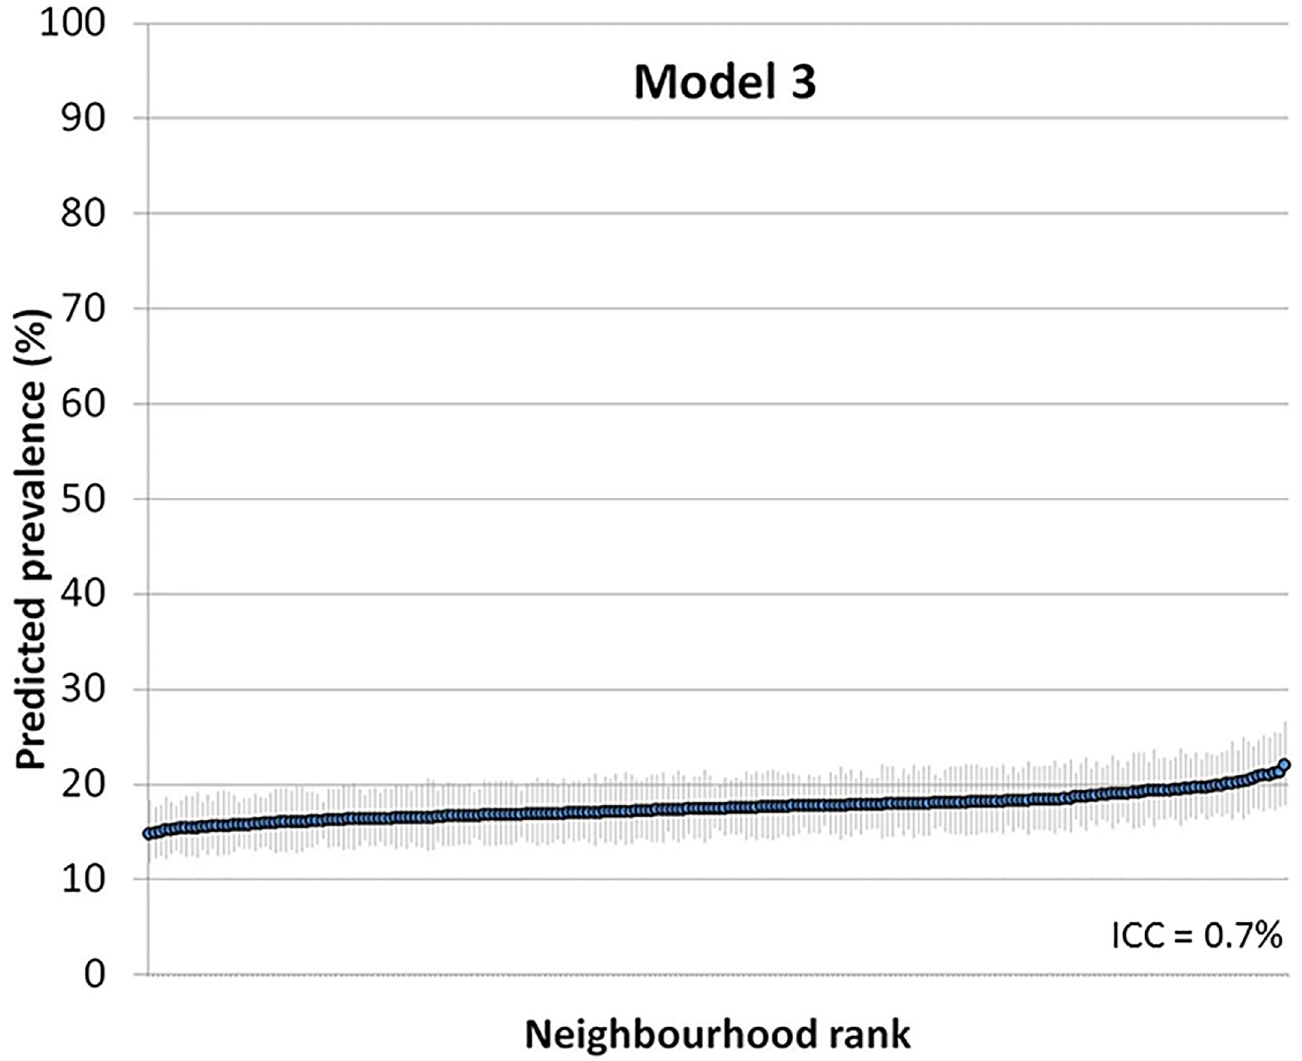
Fig 3. Predicted prevalence of psychotropic drug use in each neighborhood with 95% confidence intervals versus ranking. Predictions are for the reference individual in model 3, i.e., female, age 35 – 39, high income and living in a high income neighborhood (model